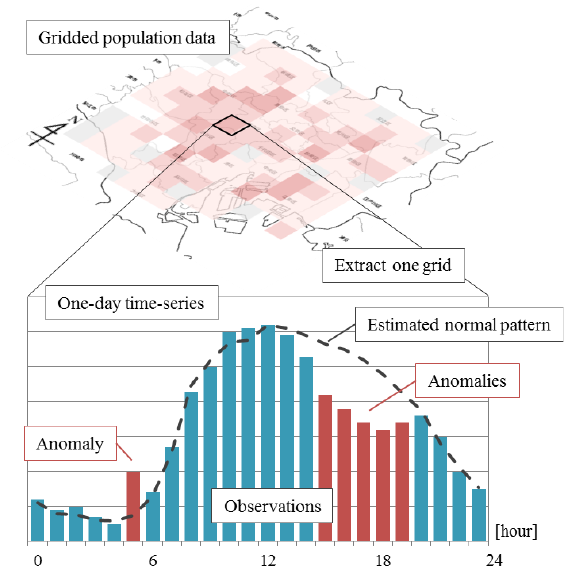
Figure 1: Anomalies in gridded population